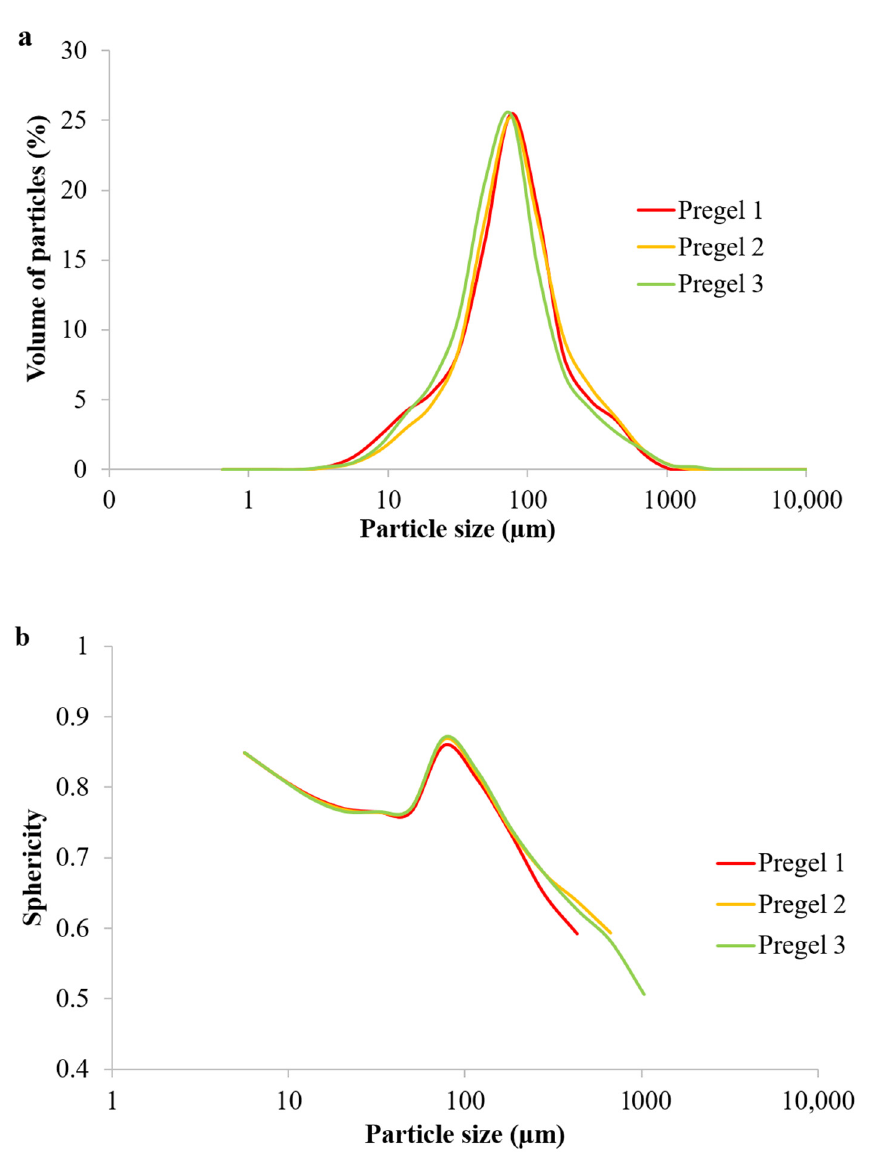
Figure 2. Particle size distribution ( a ) and sphericity ( b ) of particles in the pregelatinized wheat starches.